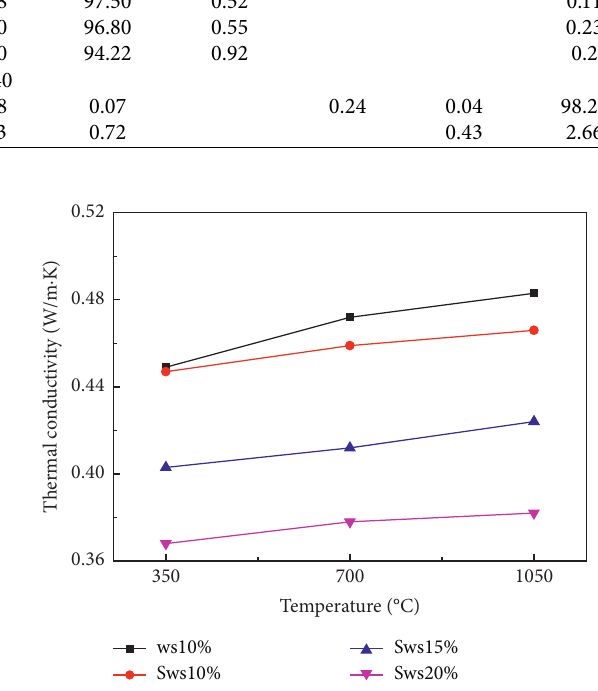
Table 4: Normal temperature performance of the sintered samples. Figure 5: Thermal conductivity of the four samples at different